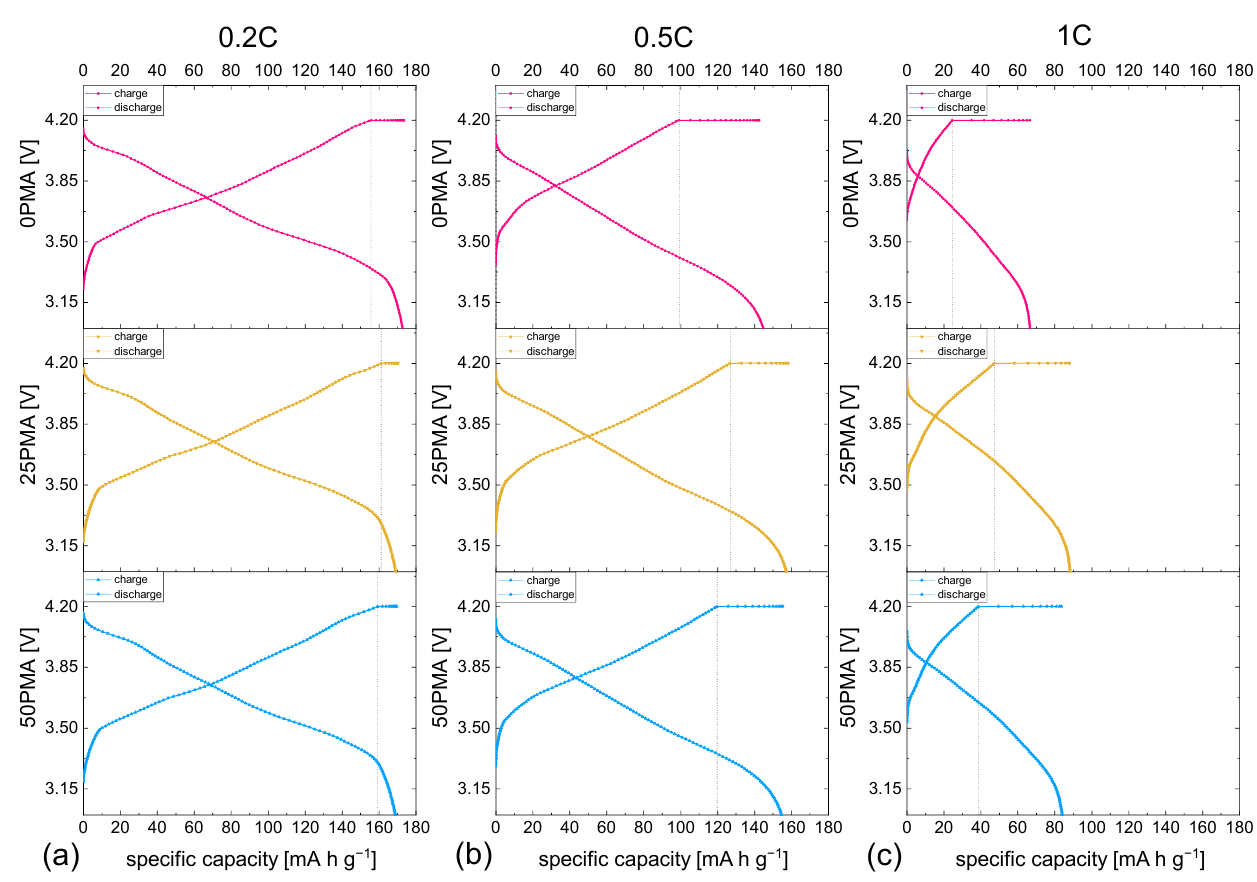
Figure 5. Voltage profiles of all samples at different C-rates ( a ) 0.2C, ( b ) 0.5C, ( c ) 1C.